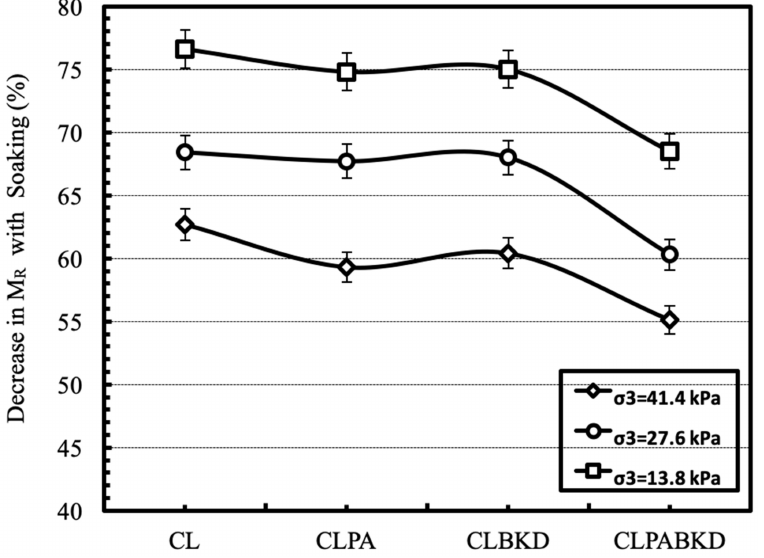
Figure 17. Average decrease in M R (%) with soaking for di ff erent optimum